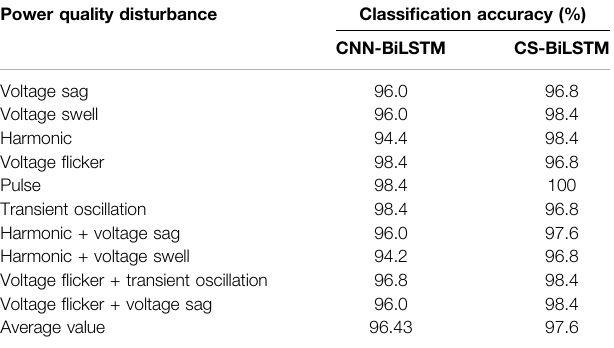
TABLE 2 | Classi fi cation accuracy of the reconstructed signal. Power quality disturbance